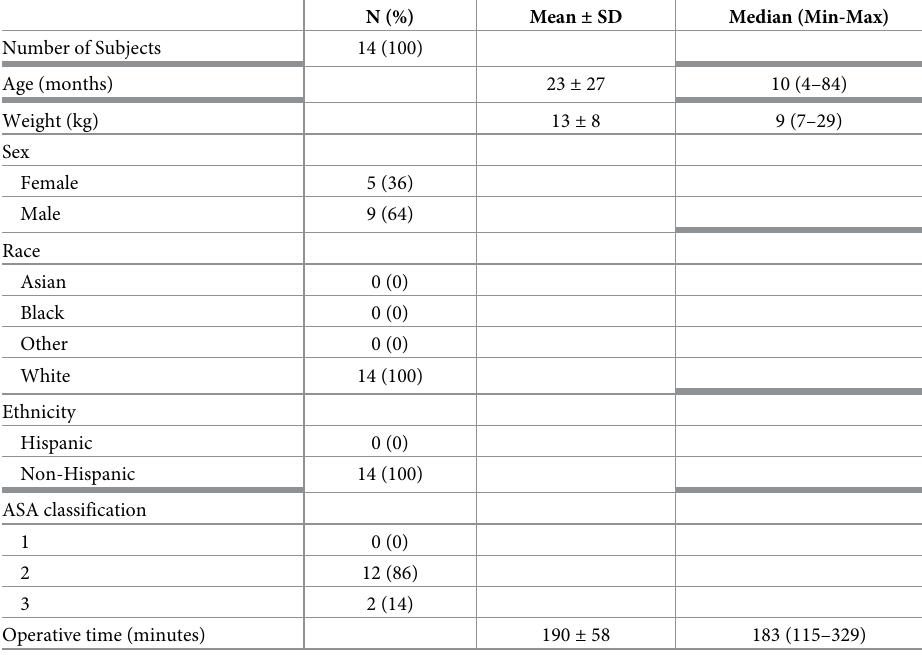
Table 1. Demographics and other characteristics.